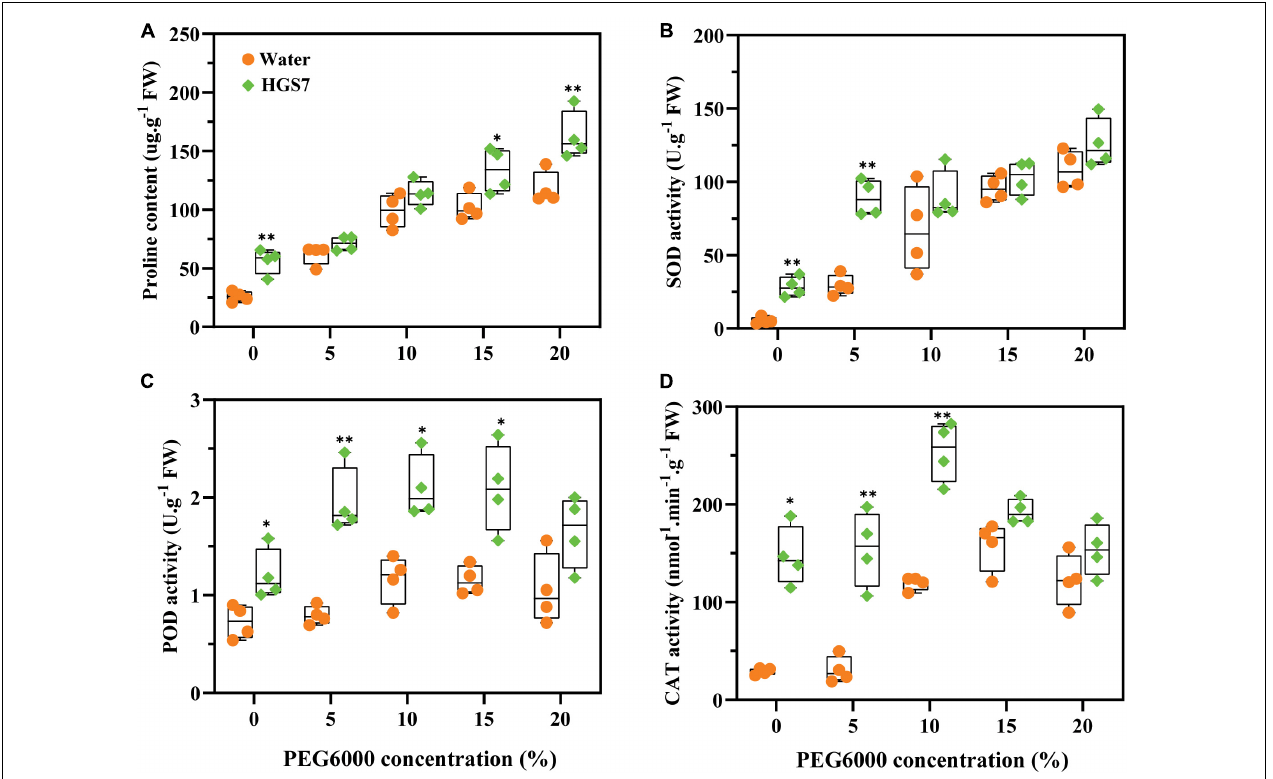
FIGURE 6 | Effects of B. megaterium HGS7 on anti-stress substrates of mulberry. (A) Proline. (B) SOD. (C) POD. (D) CAT. Data represent mean ± standard deviation ( n = 4), ** P < 0.01, * P < 0.05.